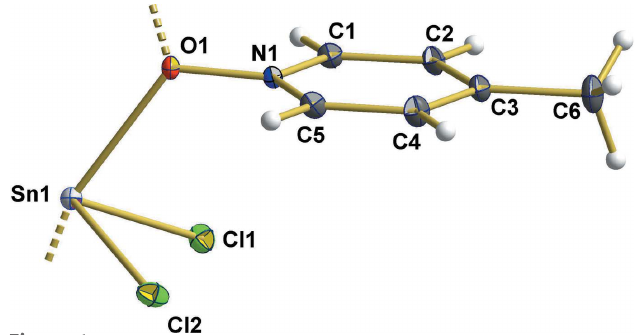
Figure 1 The asymmetric unit of SnCl 2 (cid:2) MePyNO, 1 , with the atom-numbering scheme; with the exception of the hydrogen atoms (which are shown as spheres with arbitrary radius) all atoms are drawn with displacement ellipsoids at the 40% probability level; longer Sn—O bonds expanding the coordination sphere of the tin(II) atom from three, trigonal– pyramidal, to four, seesaw, are drawn as dashed